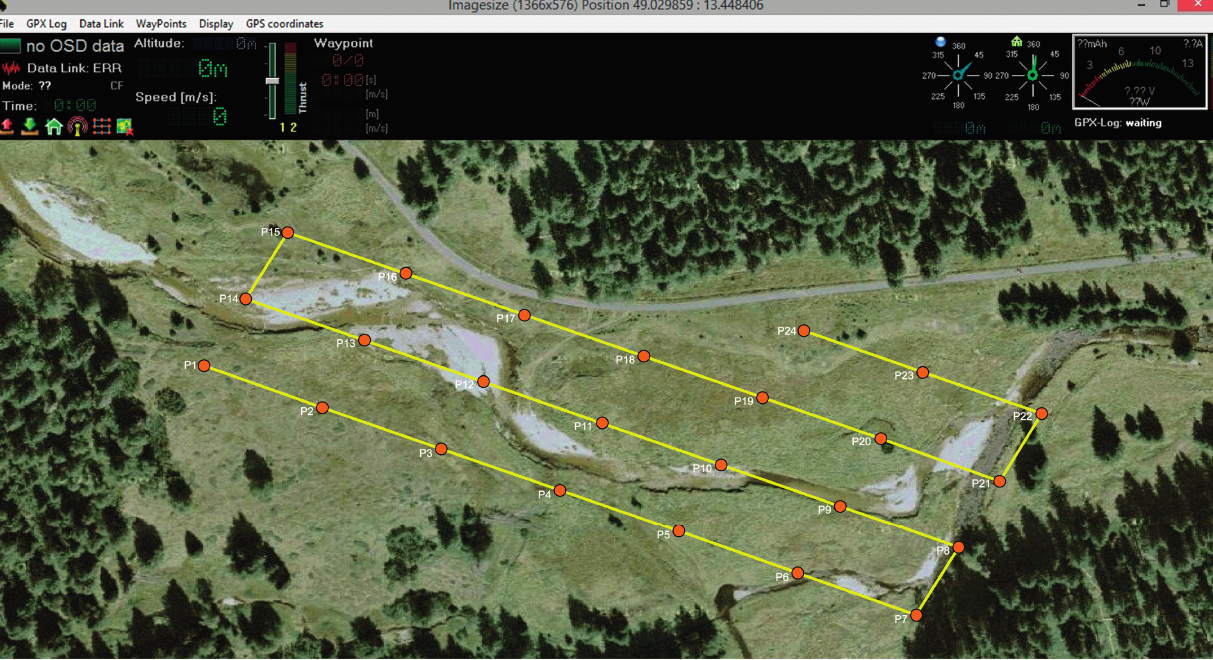
Figure 3. Graphical interface of the flight planning software with highlighted flight lines and waypoints. Screenshot from MikroKopter flight planning